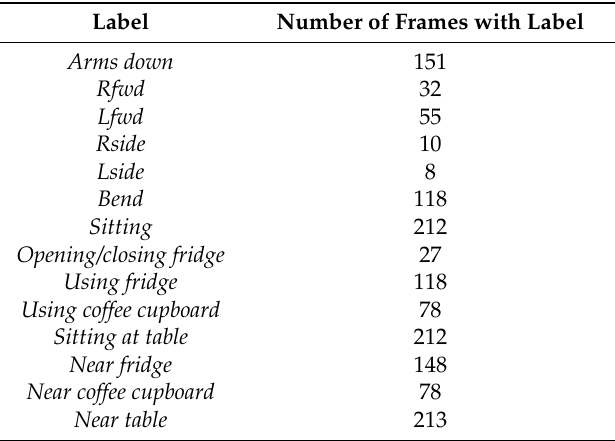
Table 3. Number of frames containing each label.